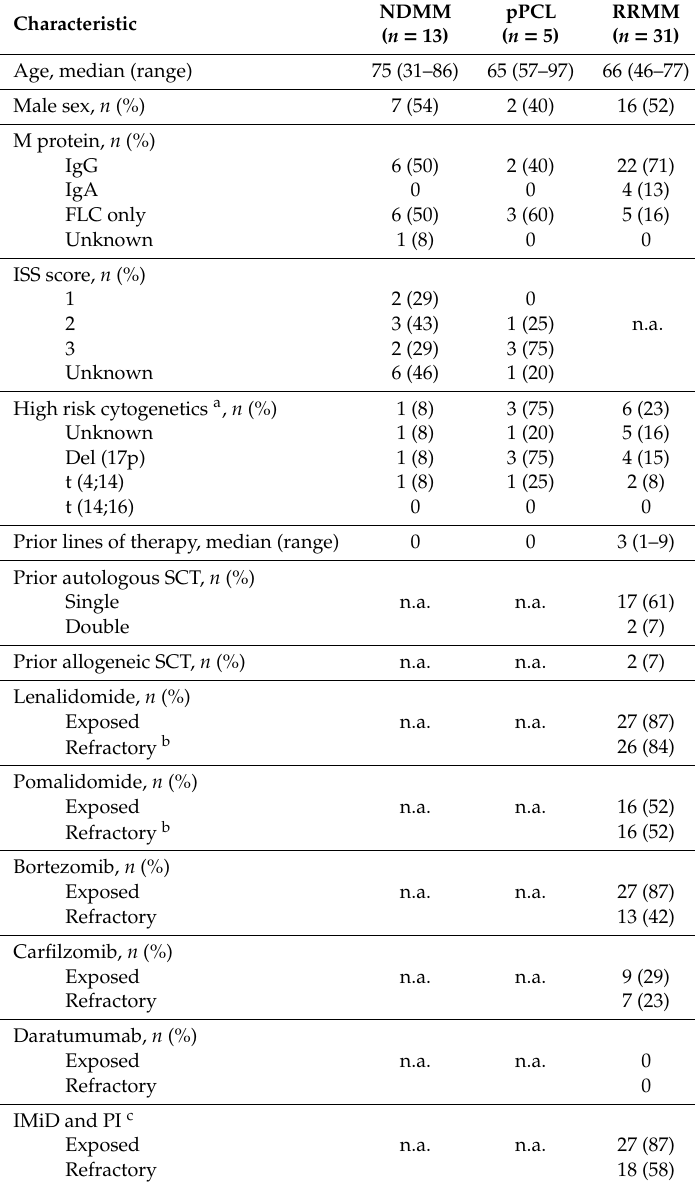
Table 1. Patient